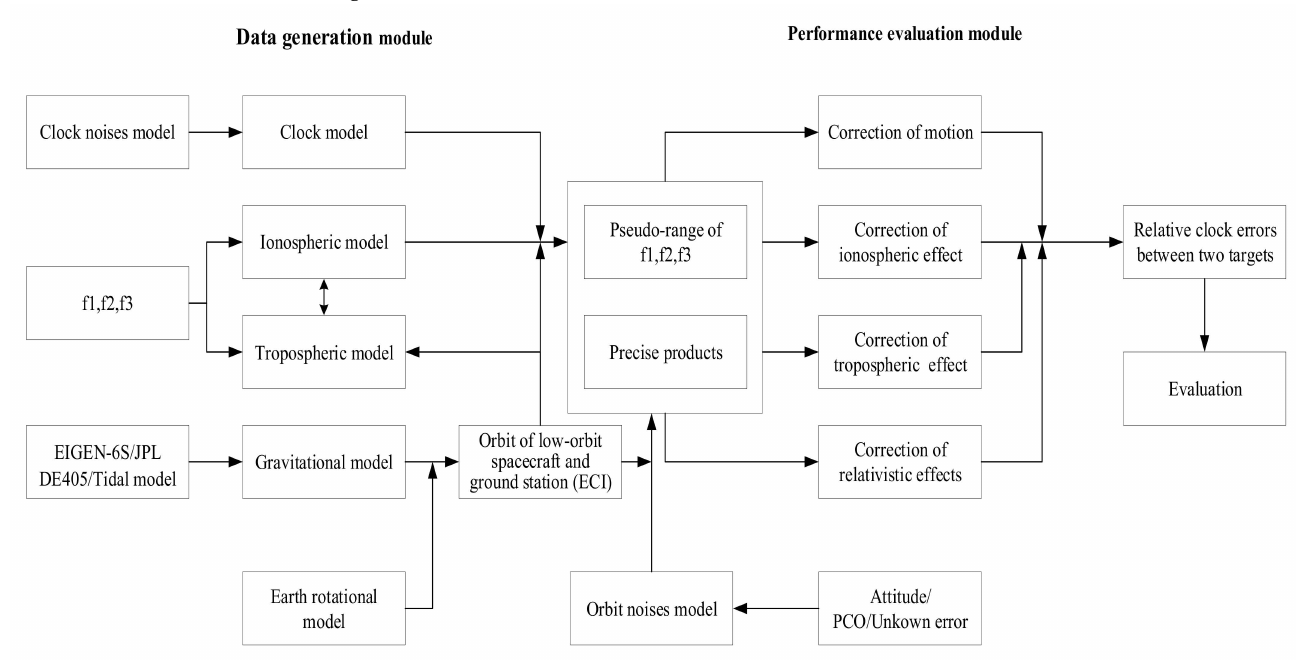
Figure 3. Simulation